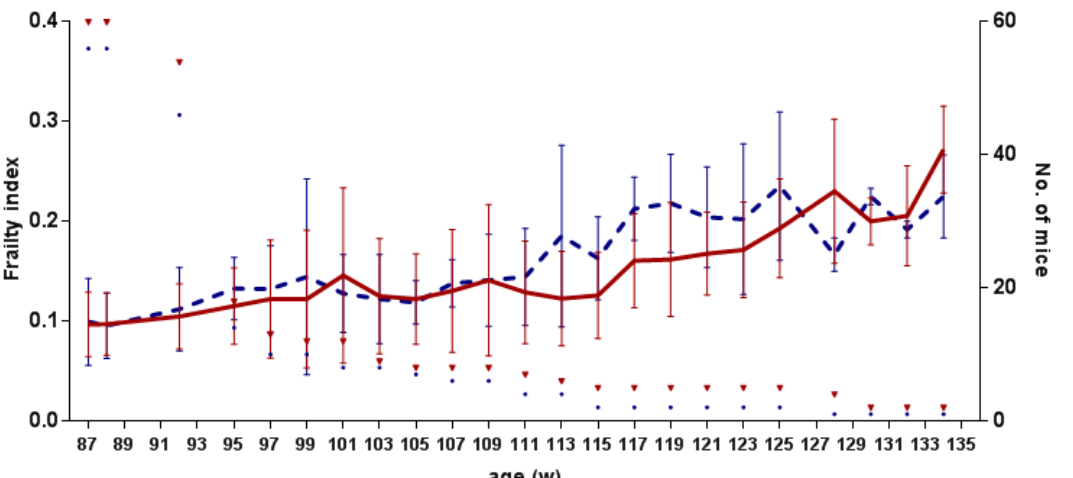
Figure 3. Frailty index (FI) results are shown in the combined plot. The x -axis shows the age of mice in weeks, the y -axis ( left ) shows FI (±SD) values, and ( right ) the number of analyzed mice. Legend: Solid line—BMT—transplanted aged group, dashed line—SHAM—aged control group, ∇ —number of evaluated BMT mice, number of evaluated SHAM mice.